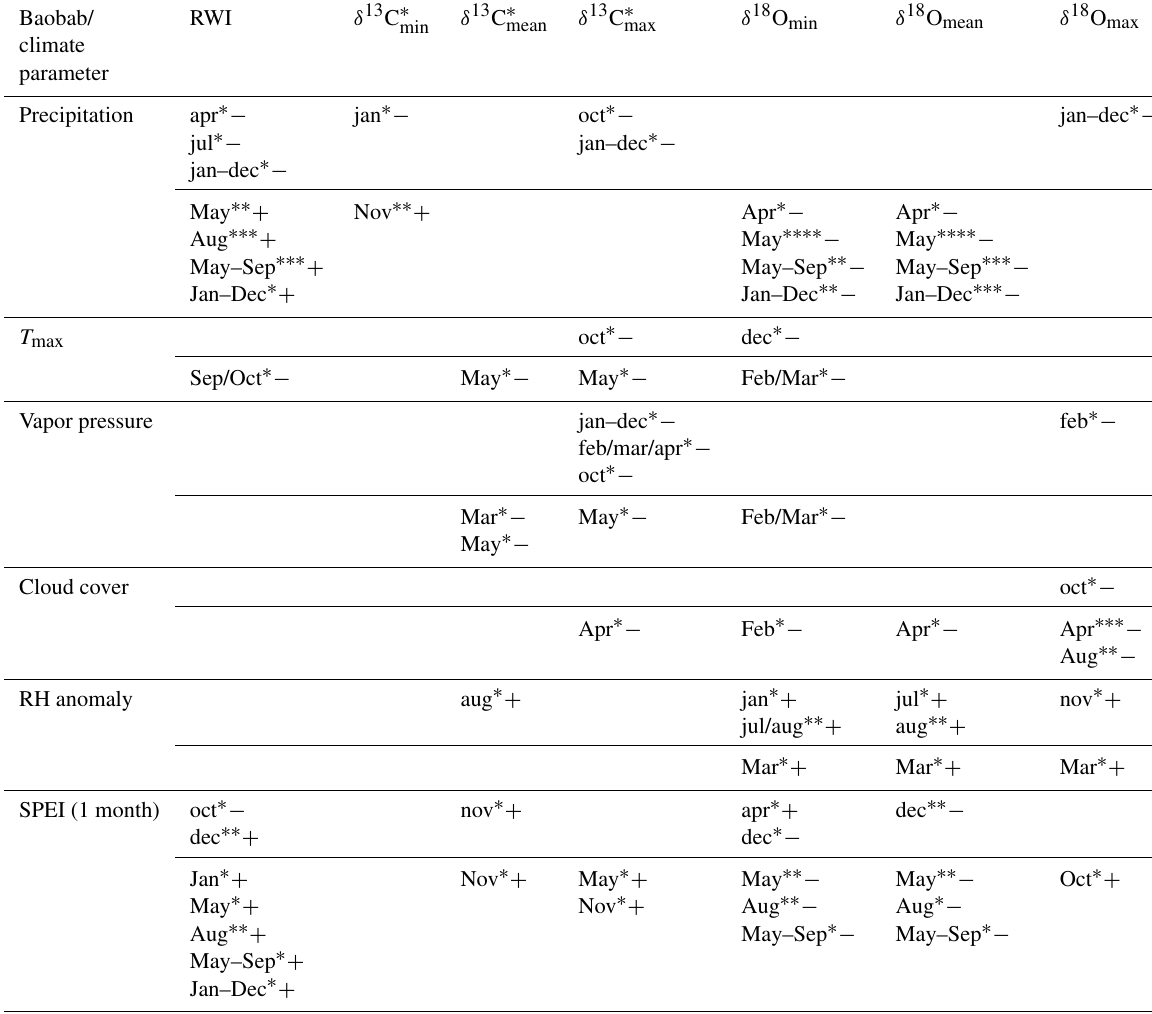
Table 3. Significant correlations between the obtained baobab time series and climate parameters for the area around Wadi Hinna. Corre- lations within months of the current year are marked by uppercase abbreviations and correlations within months of the previous year by lowercase abbreviations. Significance level values: ∗ p< 0 . 05; ∗∗ p< 0 . 01; ∗∗∗ p< 0 . 001; ∗∗∗∗ p< 0 . 0001. Positive (negative) correlations are indicated with “ + ” (“ − “). Note that δ 13 C values show some significant but weak correlations compared to RWI and δ 18 O. δ 13 C ∗ mean δ 13 C ∗ Baobab/ RWI δ 13 C ∗ min